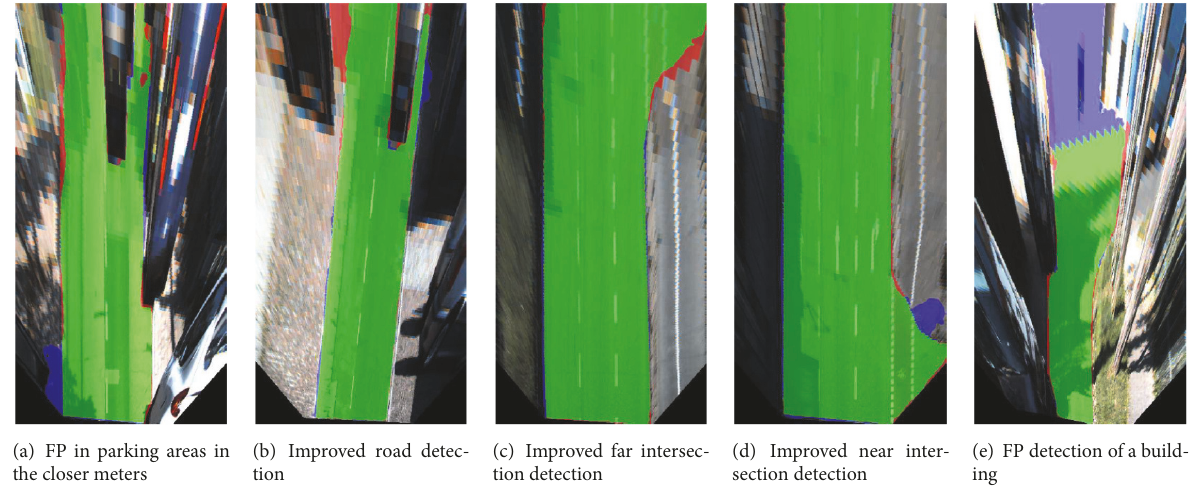
Figure 10: Results from the BEV-trained